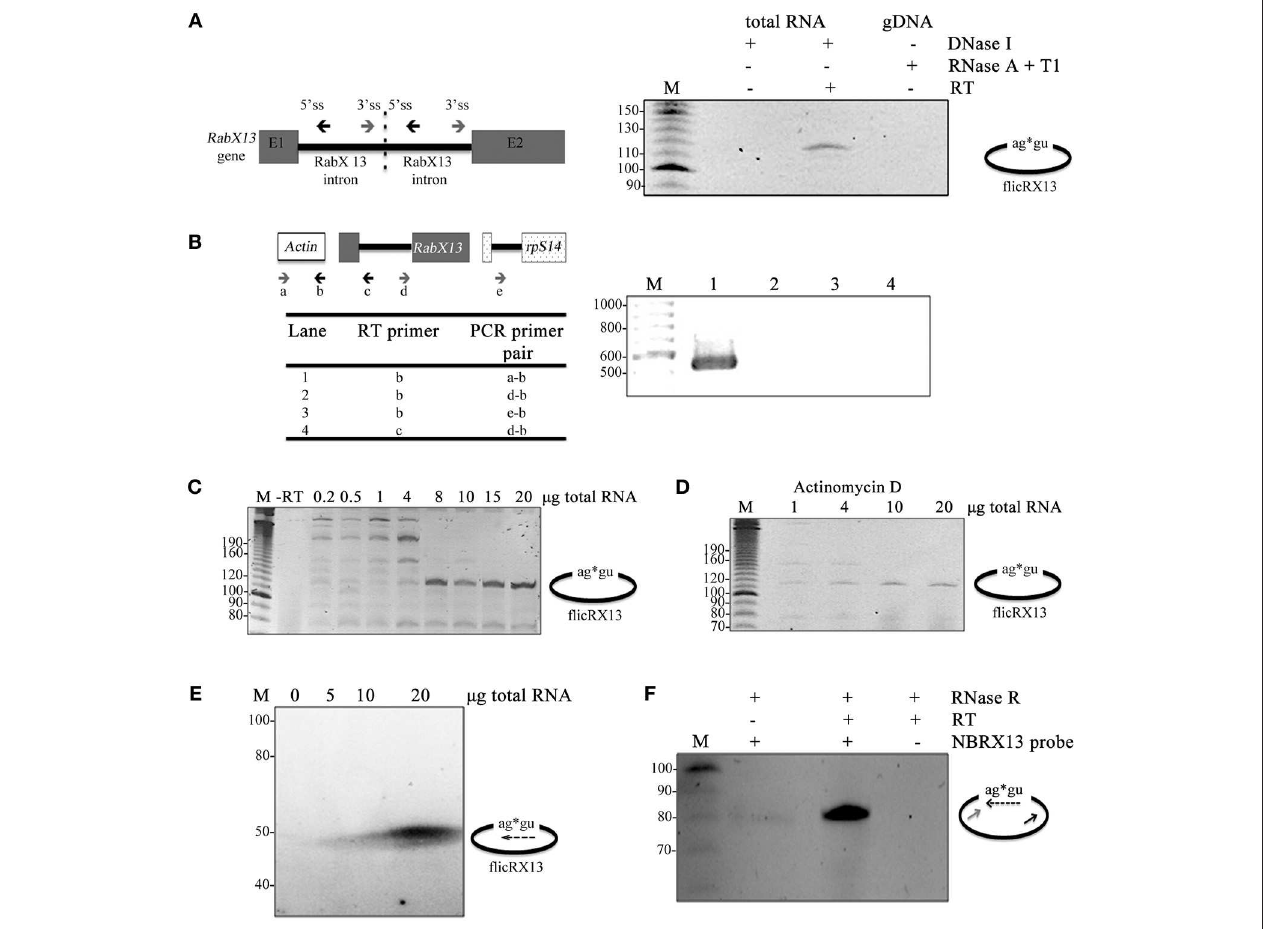
FIGURE 2 | flicRX13 is not a product of intron duplication, trans-splicing, or self-circularization events. (A) A diagram of the theoretical intron duplication event is depicted to the left showing the 5 ′ ss, the 3 ′ ss, and the outward facing primers. flicRX13 was detected only in plus RT DNase I-treated total RNA samples suggesting that no tandem templates exist in the genome. E1, exon 1; E2, exon 2. (B) Analysis of the possible intermolecular noncanonical trans-splicing events. Details are described in the text. Except for EhActin controls (lane 1), no PCR products were detected suggesting that flicRX13 is not a product of either intermolecular trans-splicing nor RT jumps. (C) Increasing amounts of total RNA input in the circular RT-PCR experiments proportionally increased flicRX13 amplification, ruling out possible self-ligation events due to dilute RNA samples. (D) Addition of Actinomycin D to the RT reaction increased flicRX13 specific amplification as a function of RNA input. (E) Different amounts of total trophozoite RNAs were blotted onto nylon membrane and hybridized at full stringency with a radiolabeled probe spanning the splice site ligation points. (F) RNase R treated RNA samples were used as input for cDNA synthesis with the antisense primer of Figure 1 in the presence ( + ) or absence ( − ) of RT. Circular PCR was carried out with the sense primer and the probe used in (E) . Numbers to the left of the gel images indicate the bp ladder